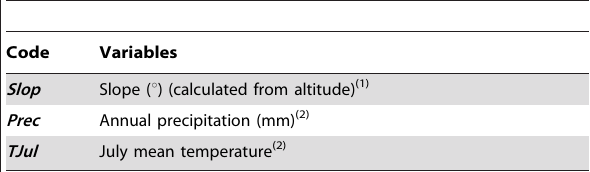
Table 1. Variables used to model the species distribution. Table 2. The combination of AOGCMs and scenarios used in this